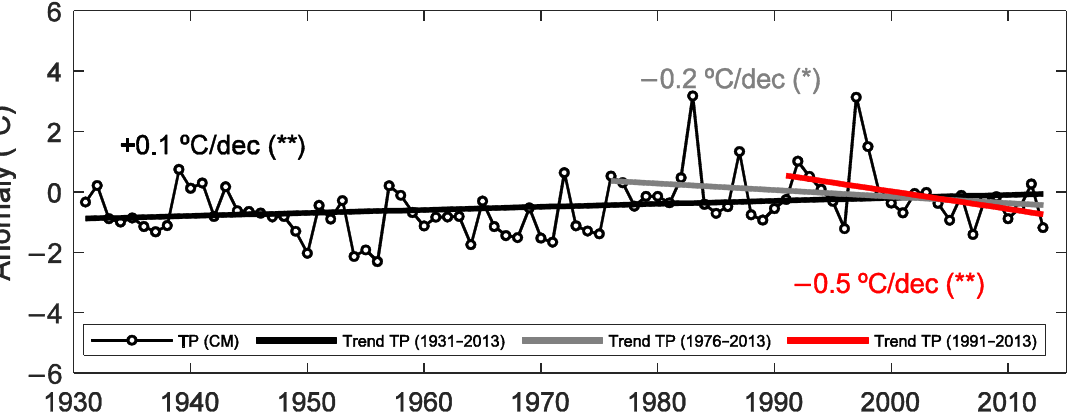
Figure 6. Linear trends of the reconstructed average temperature (TP) in central Lima (CM station) for the periods 1931 – 2013 (black line), 1976 – 2013 (gray line), and 1991 – 2013 (red line). ** Statistically significant trends at the 95% confidence level ( p < 0.05). * Statistically significant trends at the 90% confidence level ( p < 0.10).